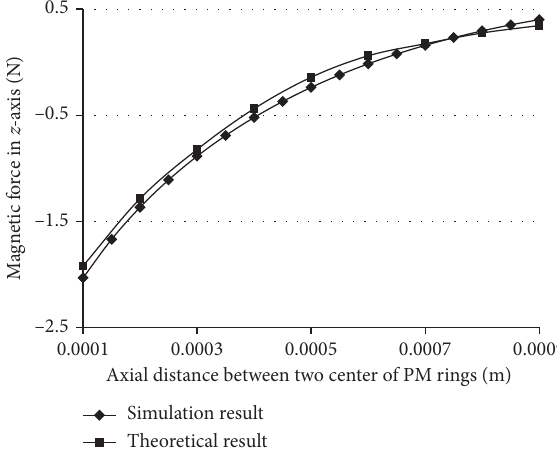
Figure 12: The electromagnetic force acting on the rotor in a circle at different rotating